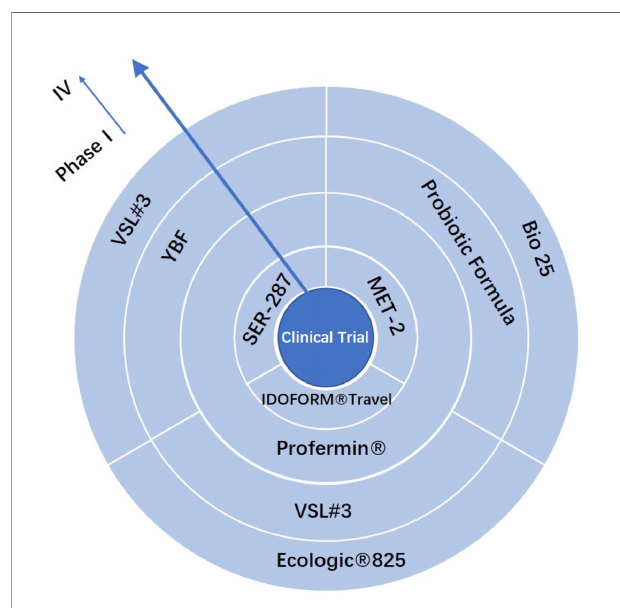
FIGURE 1 | Arti fi cial consortium transplantation products with clinical